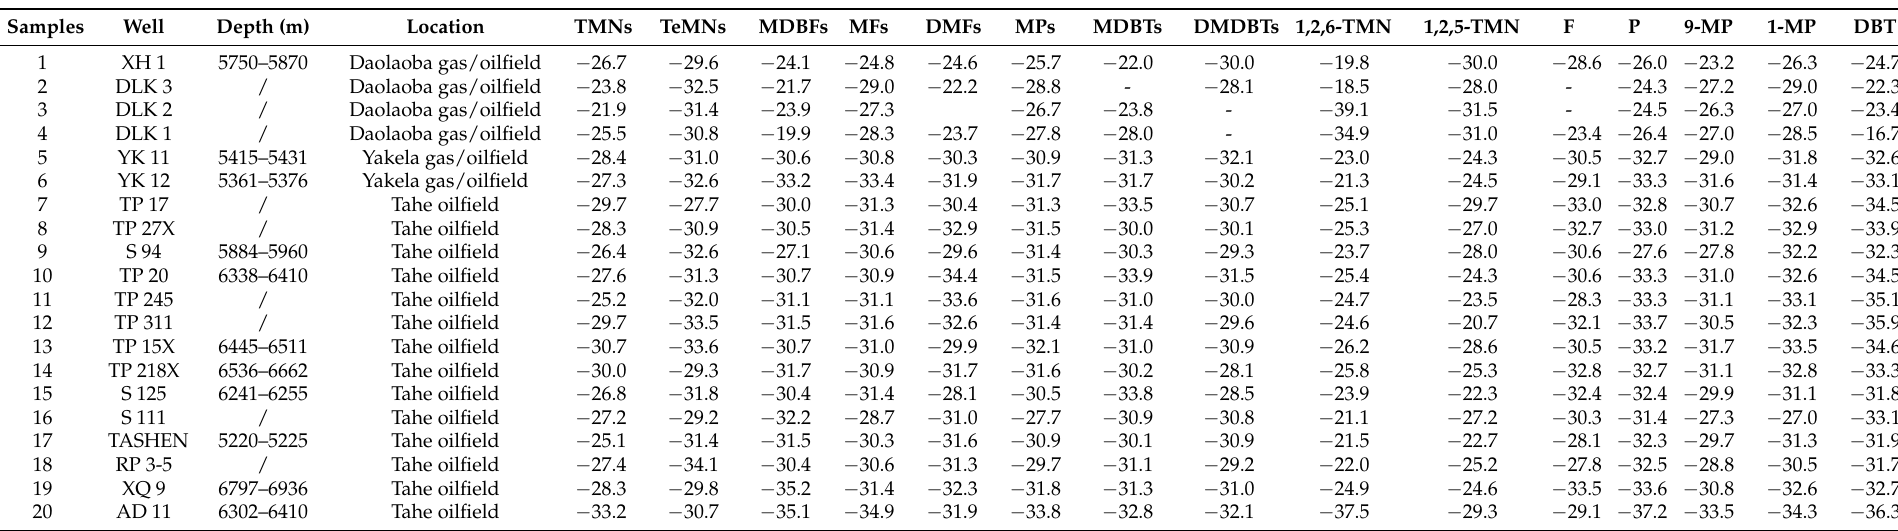
Table 2. List of crude oils and related individual and sub-classes’ carbon